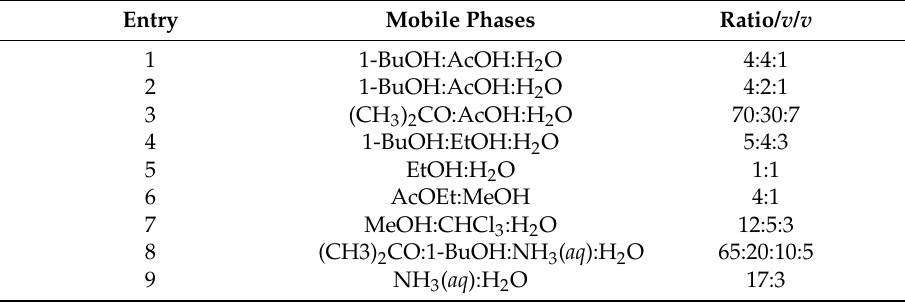
Table 1. Various mobile phases which were used for the thin layer